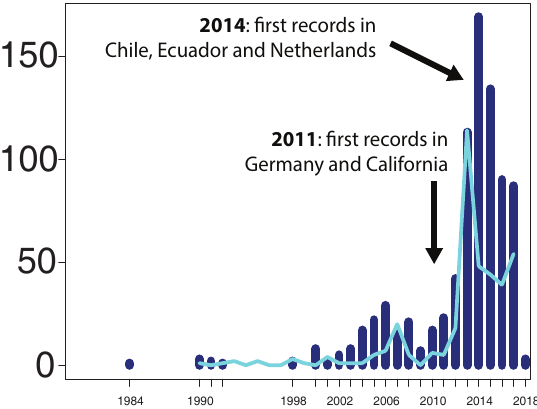
Figure 2. Increase in Spider Recording Scheme records for Steatoda nobilis in Britain parallels intensified press coverage in the local newspapers (dark blue bars = spider records, light blue line = number of press articles). The sudden massive increase in records seen in the last decade coincides with the first appearance of the species in various other countries far from the native range in the Macaronesian islands.